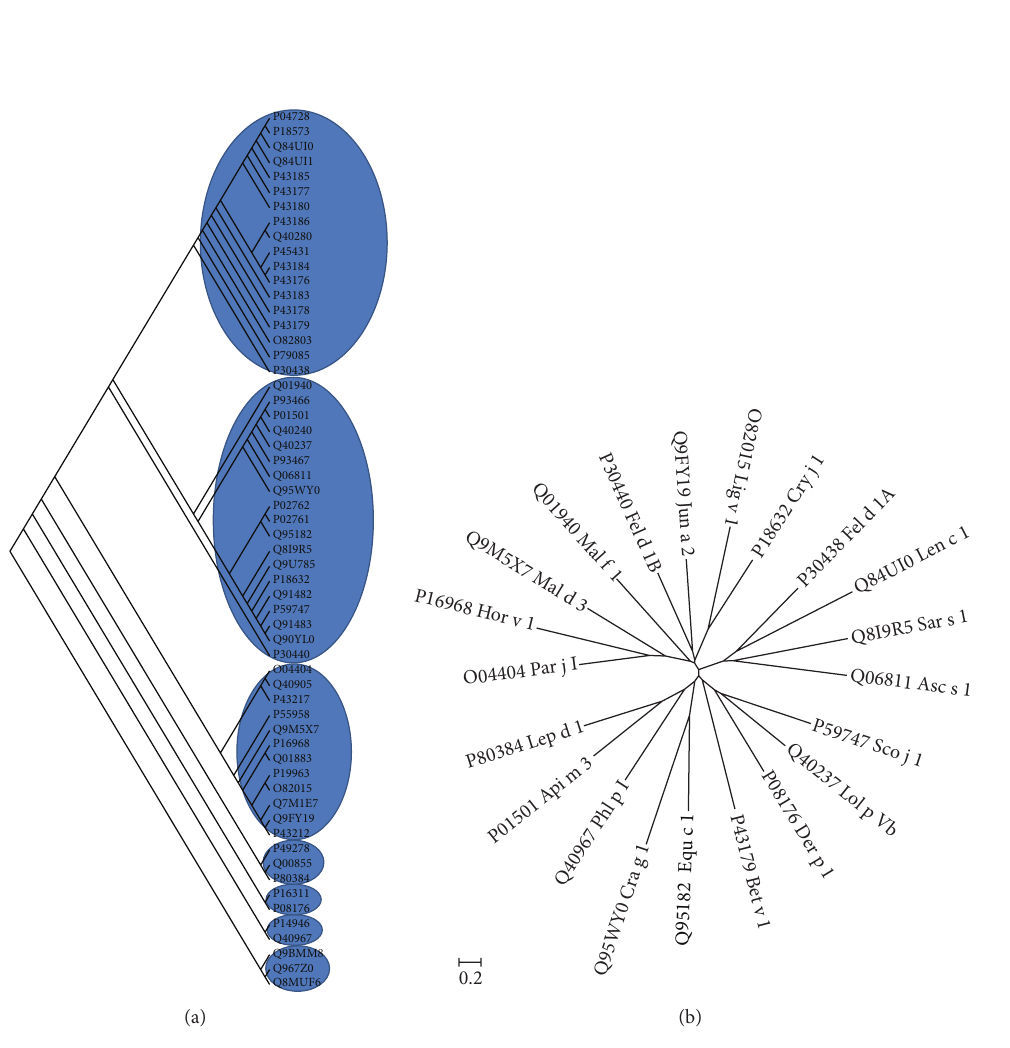
Figure 3: Progressive clustering of the major allergens acquired in UniProtKB/Swiss-Prot database. (a) Phylogeny tree of 59 major allergens constructed and tested by Maximum Liklihood from 280 major allergens. (b) Bootstrap consensus tree of 21 major representative allergens reduced from 59 major